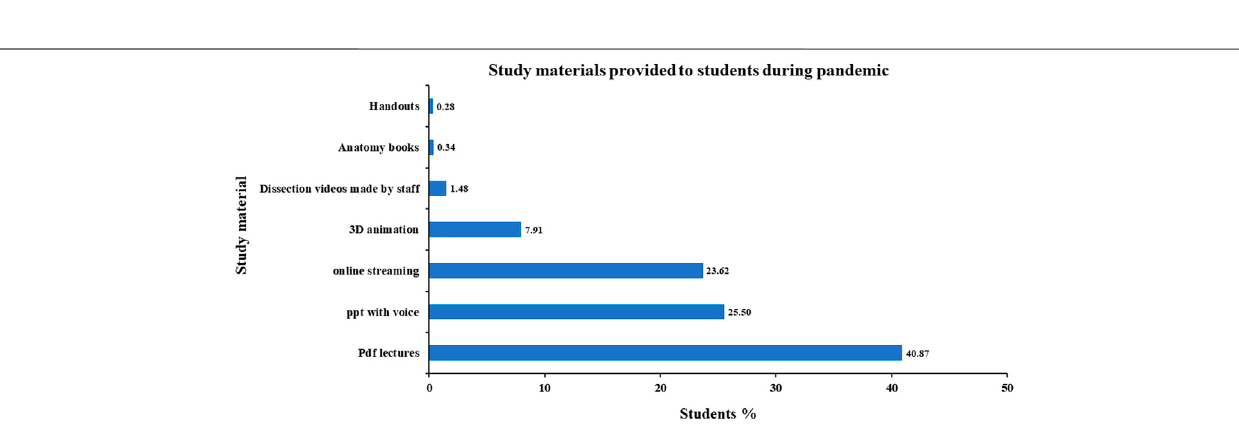
( Figure 2 ). The mean students ’ satisfaction rate with the provided